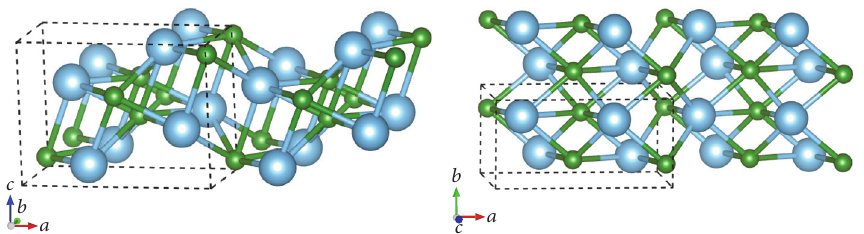
Figure 1: The 2 × 2 × 1 supercells of TiB. Blue and green balls denote Ti and B atoms, respectively. Dashed box represents the unit cell of TiB crystal.